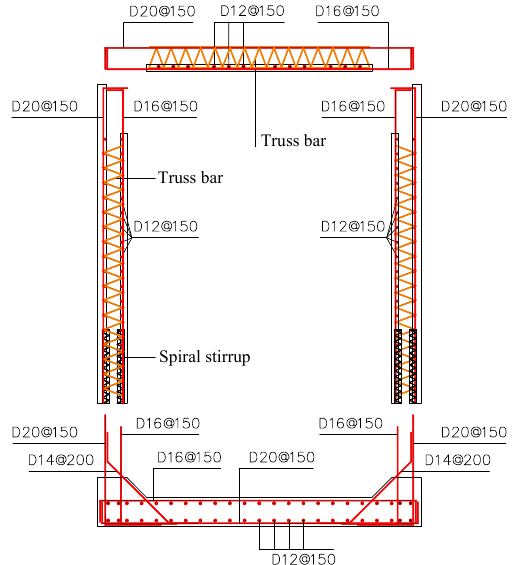
Figure 2. Reinforcement details of specimen.